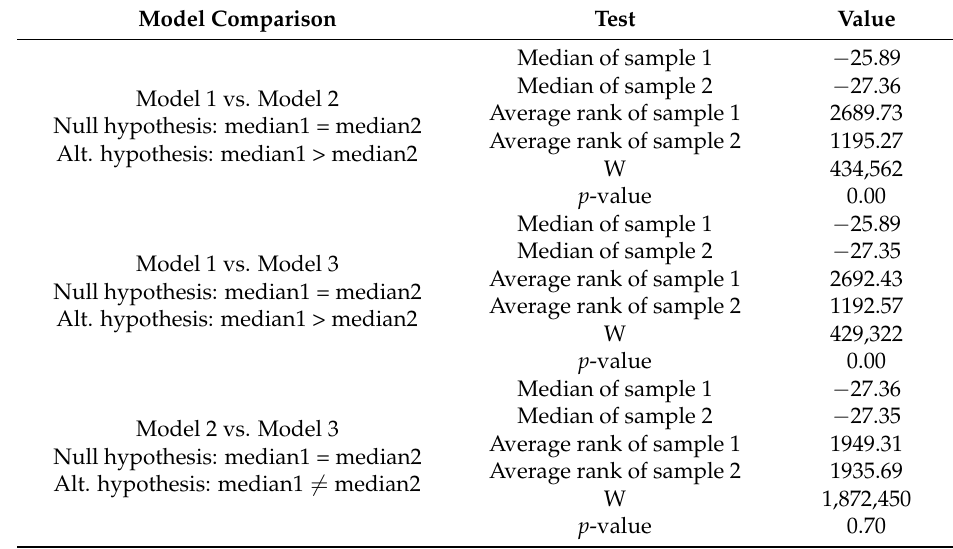
Table 6. Mann–Whitney (Wilcoxon) W-test to compare the medians of the